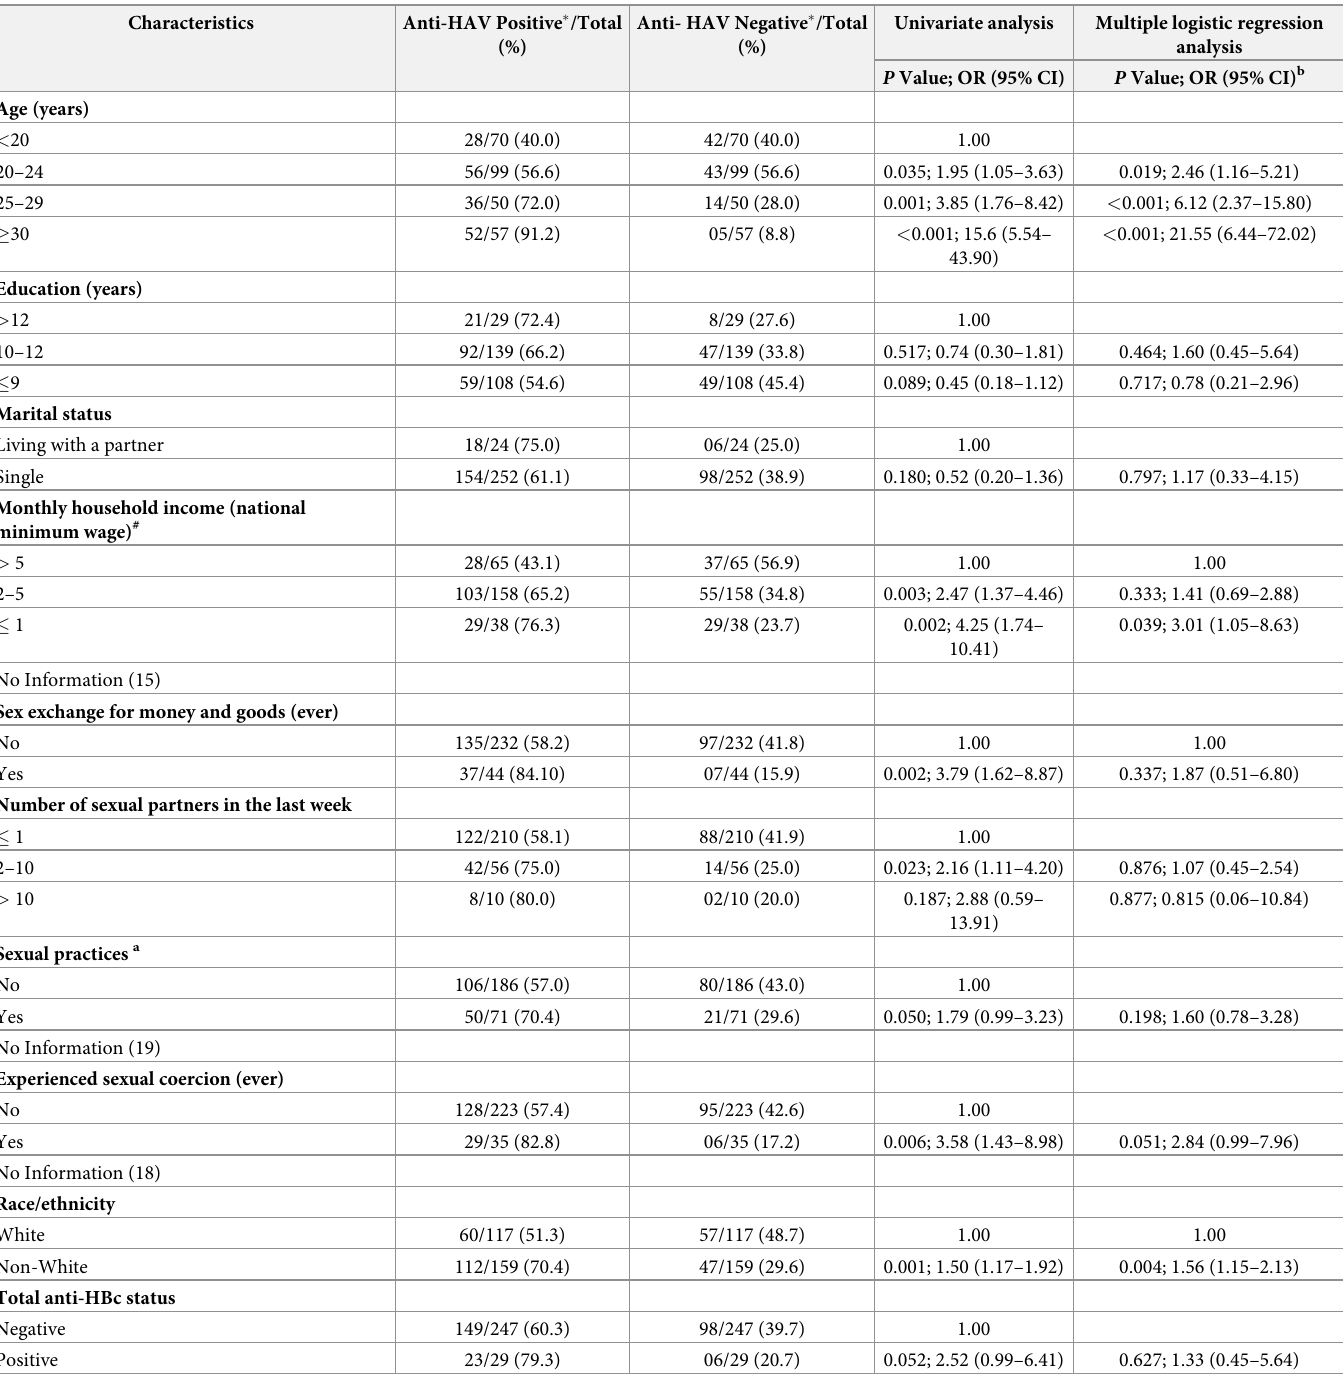
Table 1. Analysis of socio-demographic and behavioral characteristics among MSM associated with positive anti-HAV antibodies (n = 276), Central Brazil.